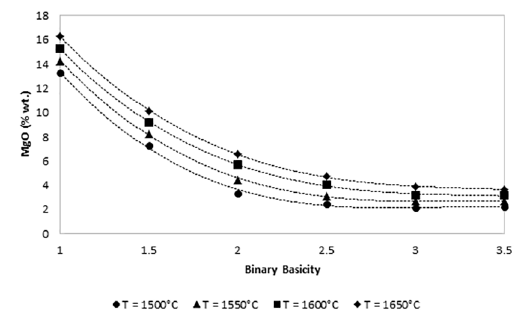
Figure 3. Chart showing MgO saturation content with binary basicity at temperatures of 1500 °C, 1550 °C, 1600 °C, and 1650 °C, and 30% FeO.